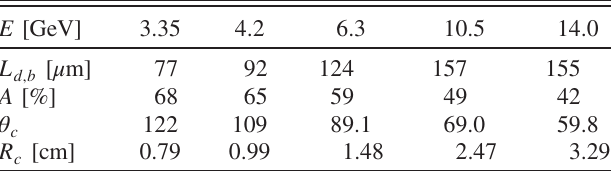
TABLE II. A table of the theoretical values for the energies of the experiment.